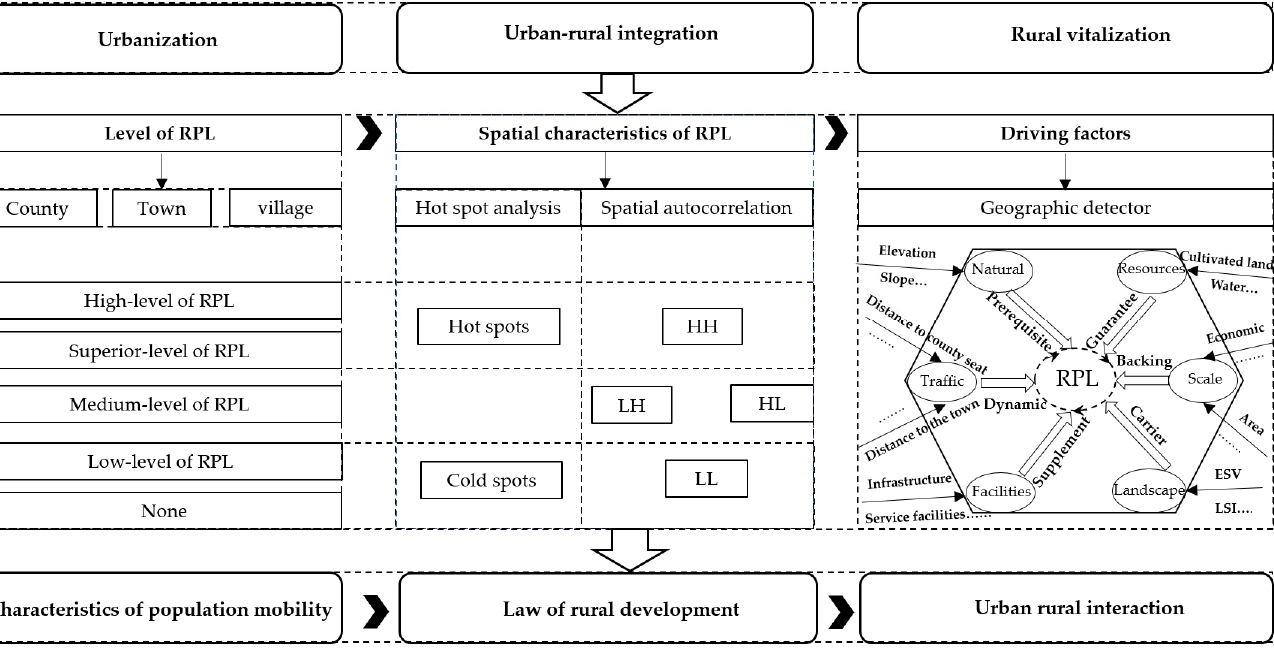
Figure 1. Theoretical framework of RPL.